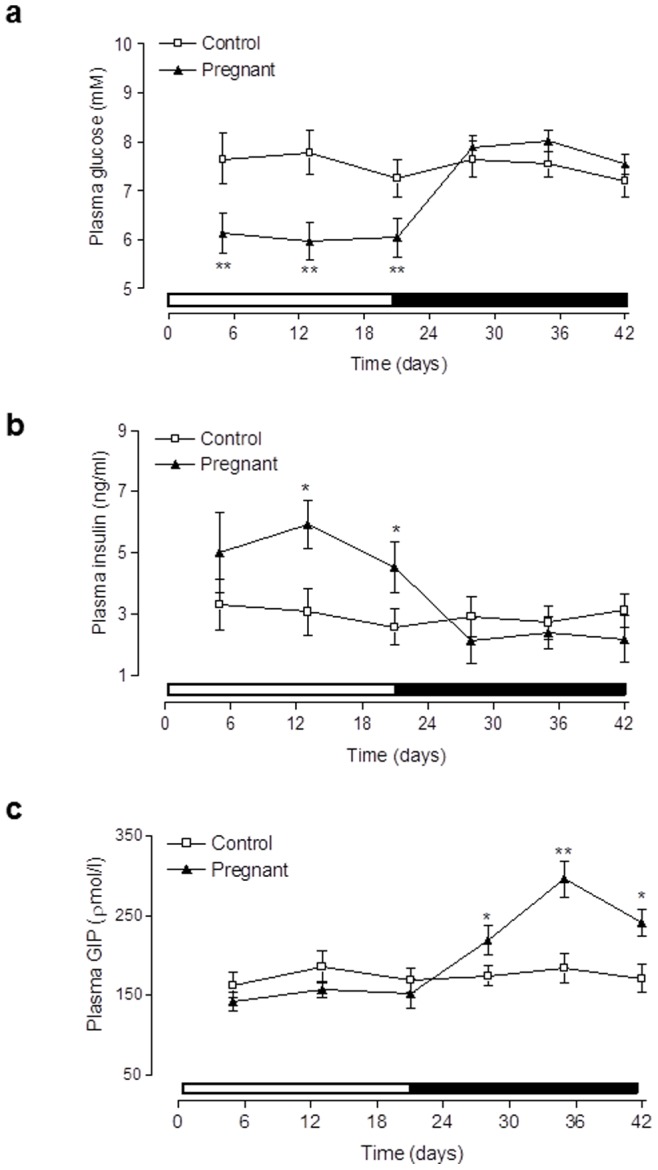
Effects of pregnancy and lactation on non-fasting plasma (a) glucose, (b) insulin and (c) GIP in Wistar rats.Parameters were measured for 21(indicated by open bar) and 21 days subsequent to parturition (indicated by black bar). Values are means ± SEM for 6 rats. * p<0.01 and ** p<0.01 compared to controls.